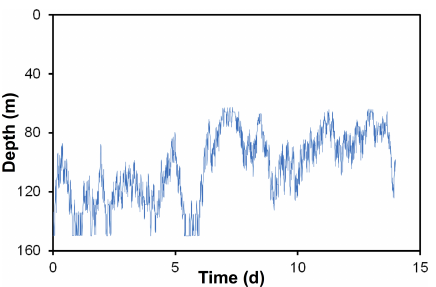
Figure 2. Prescribed head evolution inside the mine chamber 1 (CH1).